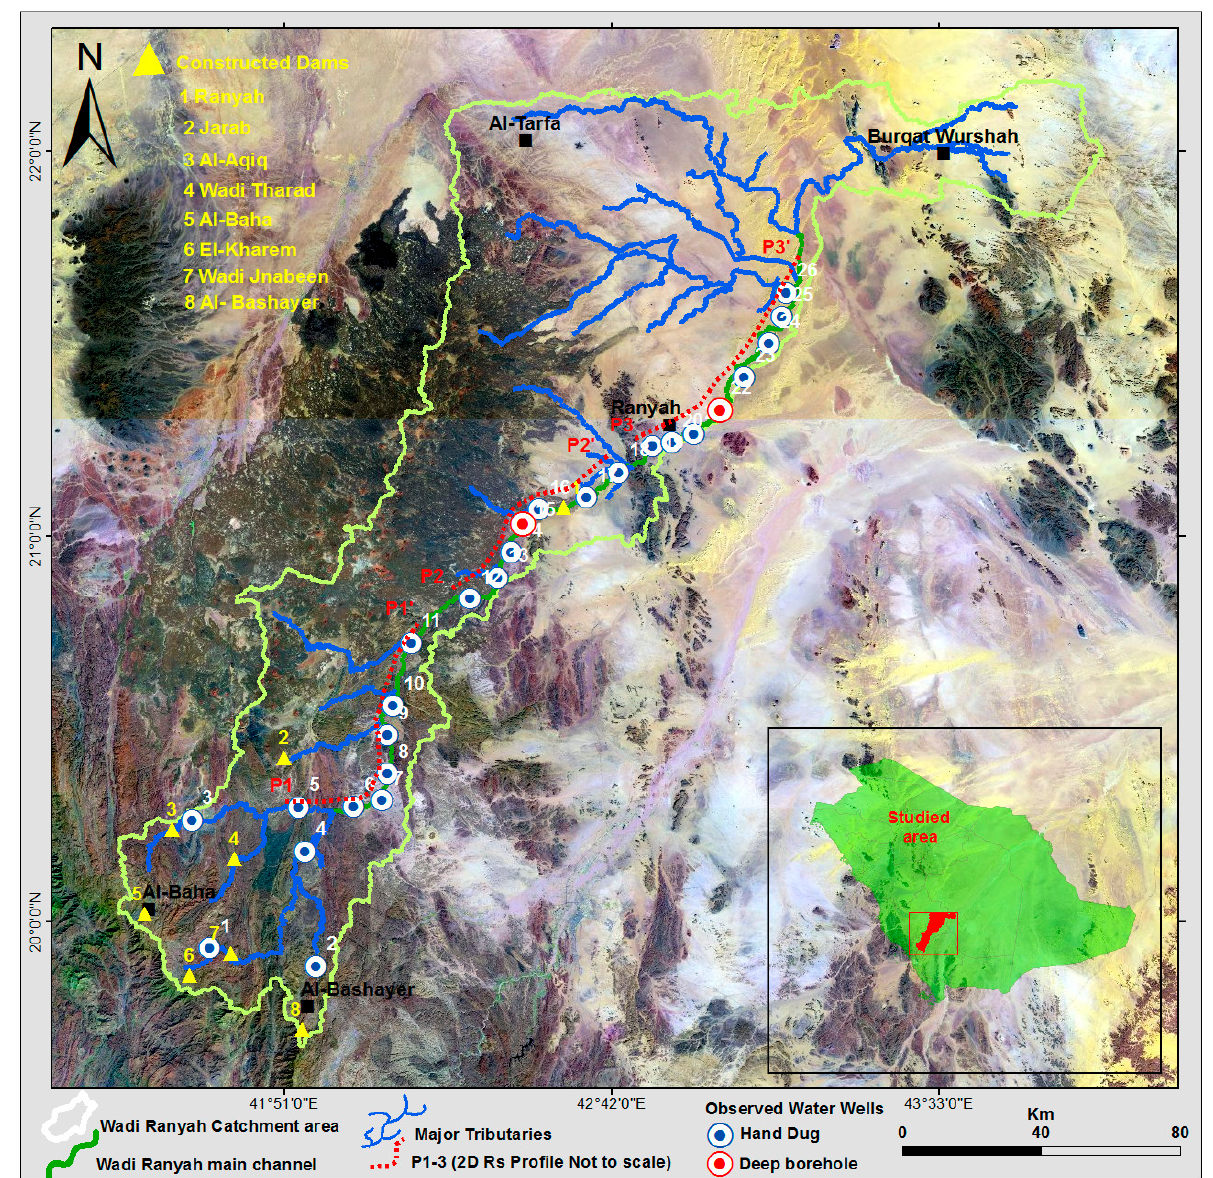
Figure 1. Location map of Wadi Ranyah showing the catchment area, main channel, boreholes, re- sistivity pro fi les, and constructed